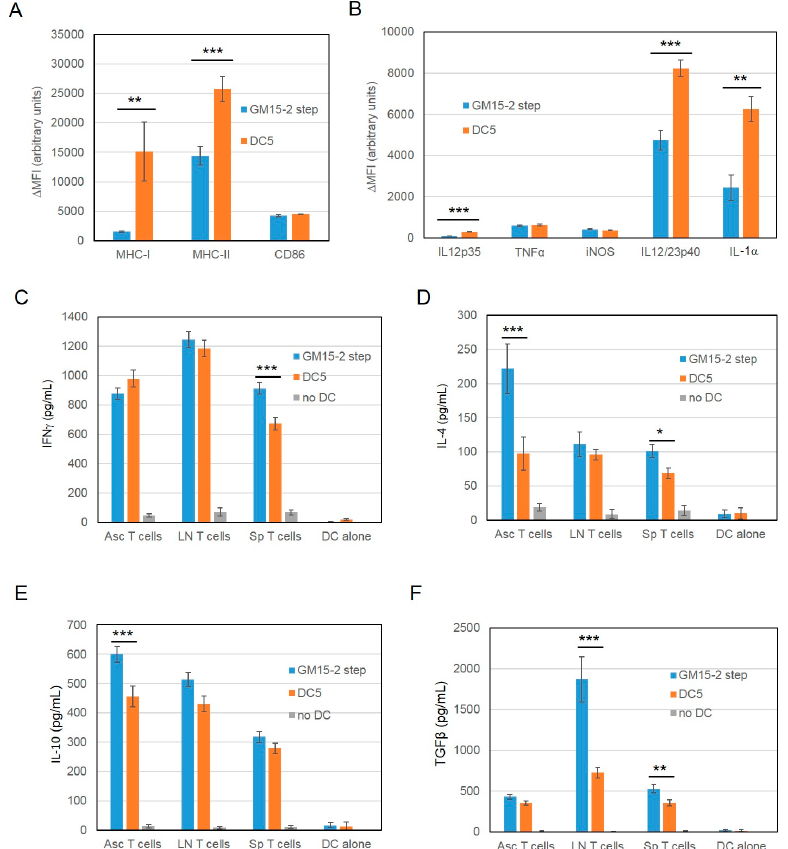
Figure 5. Blocking the prostaglandin E 2 pathway during DC differentiation and maturation improves DC phenotype and in vitro immunogenicity. ( A , B ) Isolated mouse bone marrow cells were differentiated in the presence of GM-CSF and IL-15 (GM15-2 step DCs) for 4 days or first with GM-CSF and IL-5 for 24h then supplemented with anti-PGE2, anti-EP2 Ab (DC5); cells were then pulsed and matured as reported in Figure 3 for GM15-2 step DCs with the addition of anti-PGE2, anti-EP2 Ab for DC5 throughout the cell culturing period. Cell phenotype was then analyzed by FACS staining and the net mean fluorescence intensity ( Δ MFI = Raw MFI-MFI of Isotype) for each marker was reported in the graph. ( C – F ) Levels of indicated cytokines measured by ELISA, produced after 24 h co-culturing of T-lymphocytes isolated from the ascites (Asc), lymph node (LN), or spleen (Sp) of tumor bearing animals with the indicated DC formulations pulsed with an ID8 tumor cell lysate treated with squaric acid. Data are representative of at least 3 independent experiments. Significant differences were assessed with unpaired Student’s t test and indicated with asterisks: * p < 0.05; ** p < 0.01; *** p < 0.005. (CpG: CpG oligonucleotides; DC: dendritic cells; EP2: PGE2 receptor; GM-CSF: granulocyte-macrophage colony-stimulating factor; IL-15: interleukin-15; PGE2: prostaglandin E2).